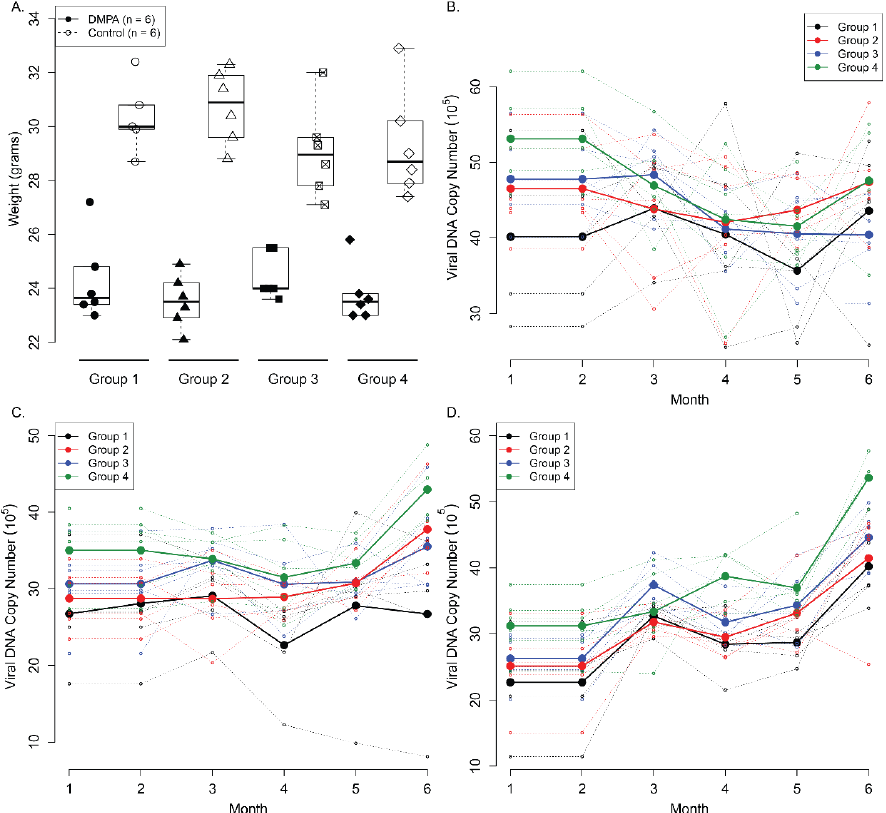
Figure 6. Comparable viral DNA was detected in lavages of both lower genital and anal tract in different groups. Female athymic Hsd: Nu Mice with equivalent weight were distributed into four groups ( n = 5) treated with PBS (group 1), DMPA (group 2), Cilostazol (group 3), and17 β -estradiol (group 4) at one month post viral infection and treated for up to nine months. Mice from all four groups showed even weight gain at six months post viral infection ( A ). Viral DNA was detected by collecting lavage samples following with qPCR analysis. No significant difference in viral detection was found at both vaginal ( B ) and anal ( C ) lavages among the four groups at all time points ( p > 0.05, Wilcoxon rank sum tests). We also monitored secondary infection at the oral cavity by collect- ing oral lavage ( D ) and no significant difference was found ( p > 0.05, Wilcoxon rank sum tests). The tissues were further harvested for histological analyses. As shown in Figure 7, no significant difference was found among the four groups by H&E. One representative sample from each group at nine months after infection is presented (Figure 7). Diffuse positive mild to moderate atypia with persistent differentiation toward the lumen was found in group 1 (PBS) (Figure 7, H&E). Diffuse mild to moderate atypical hyperplasia of the caudal half of the vagina with extension into the adjacent haired skin was detected in group 2 (DMPA) and 3 (Cilostazol) (Figure 7, H&E). Adjacent to the vagina there is a tissue with florid hyperkeratosis and prominent viral CPE (interpreted as en face section of cau- dal vagina) (Figure 7, H&E). Rare small foci that may represent micro-invasion and desmoplasia were found in group 4 (17B-estradiol) (Figure 7, H&E). Viral DNA and RNA were detected by in situ hybridization as well as qPCR and RT-qPCR, respectively, as shown in Figure 7. No significant difference was found among the four groups ( p > 0.05, Wilcoxon rank sum test).